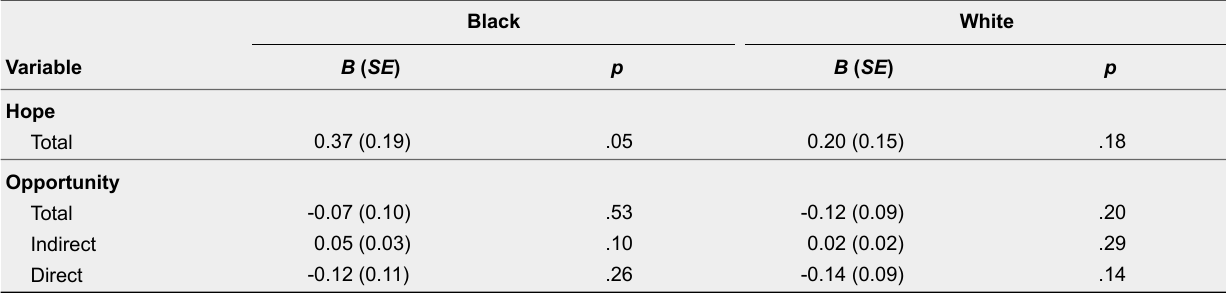
Structural Parameter Models – Total and Indirect Effects of Opportunity Treatment and Hope on Letter Signing, Across Subject Race